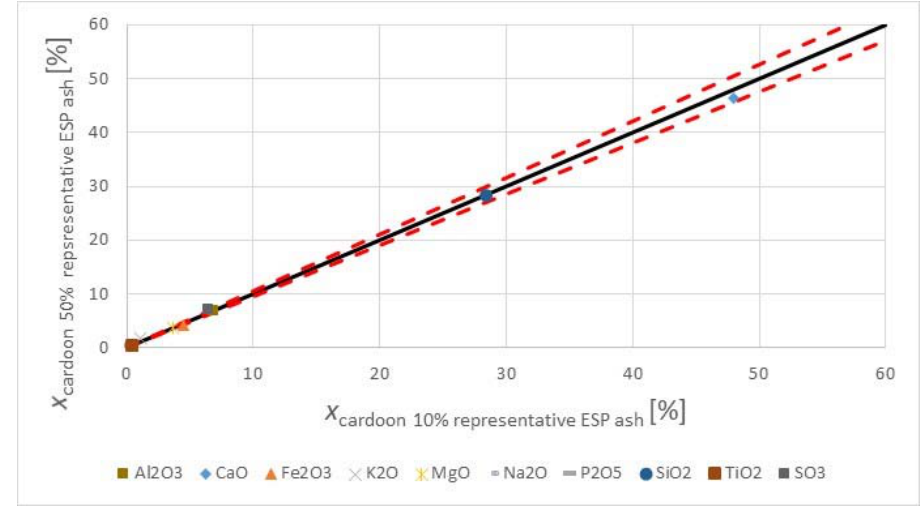
Figure 13. Enrichment of elements in the fly ash compared for 10% thermal share of Cynara and 50% thermal share of Cynara ; 10% thermal share of Cynara plotted on the abscissa and 50% thermal share of Cynara plotted on the ordinate; dashed lines estimate the uncertainty of analyses variability (±5%).